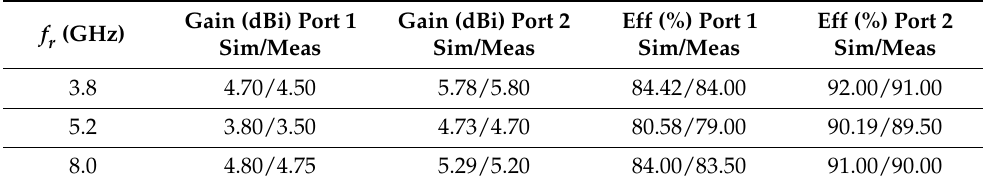
Figure 10. The radiation efficiency and simulation and measurement gain of the proposed Multiple Input Multiple Output (MIMO) (Gain in dBi, Eff: Efficiency in%). Table 2. The radiation efficiency and gain of the proposed MIMO antenna at the resonance frequencies (Sim: Simulation, Meas: